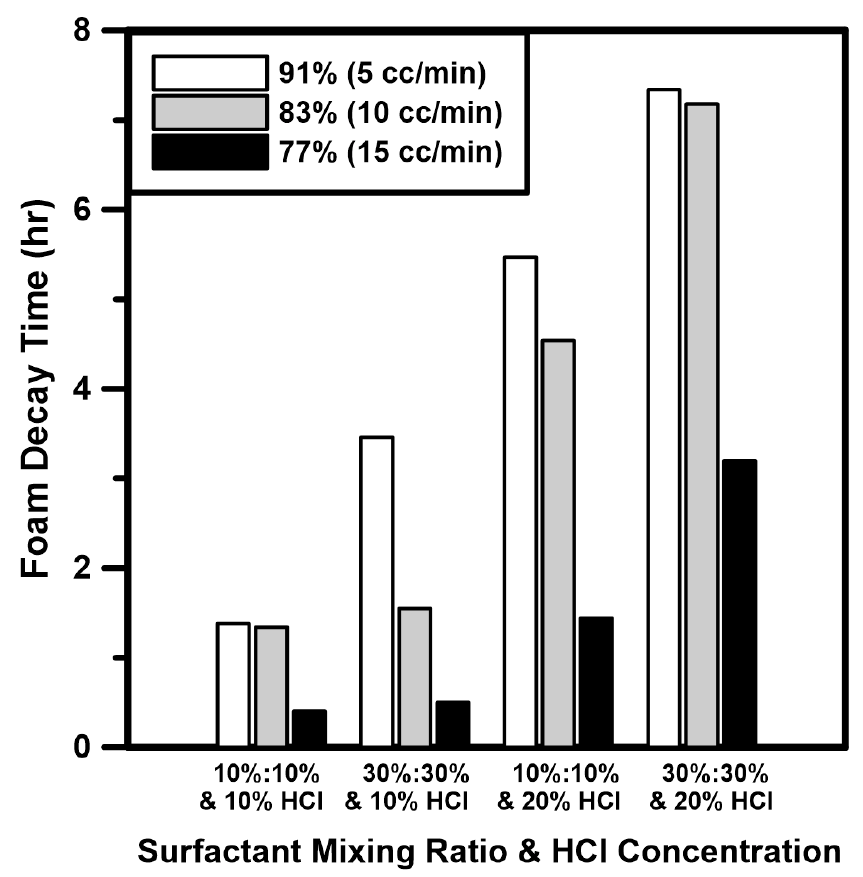
Figure 4. Foam decay time of surfactant mixture of Surfactants B and E under HPHT conditions.